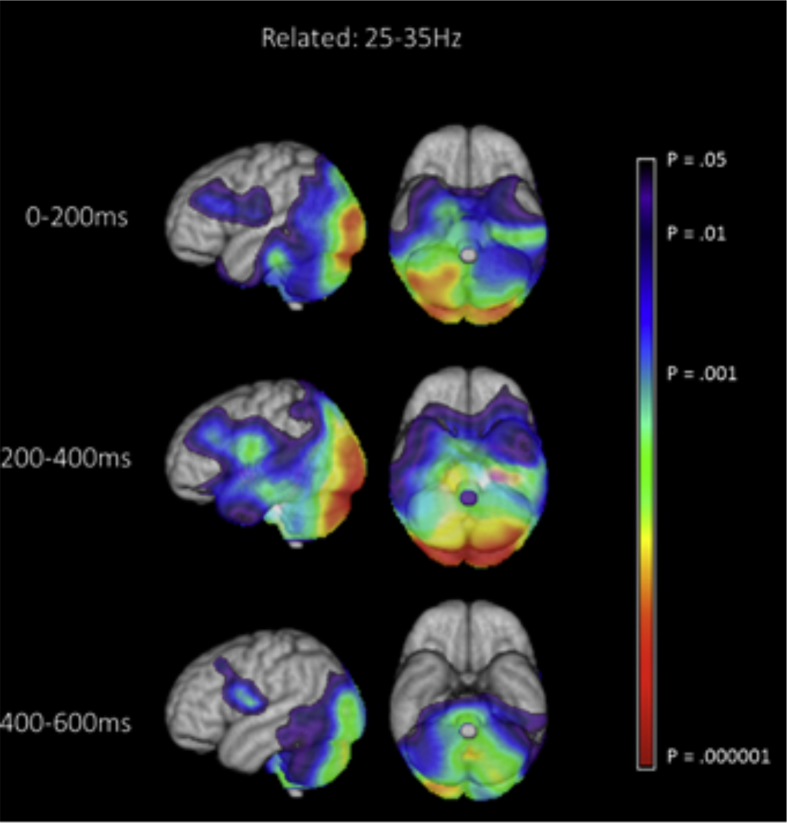
Whole-brain beamforming results for the 25–35 Hz frequency band, showing differences in total oscillatory power between an active period following target onset and a passive period prior to each trial. The first 600 msec following presentation of target word are displayed, in 200 msec windows. Task effects were decreases in total power in all cases. The images show a t-value map, thresholded at p < .05.